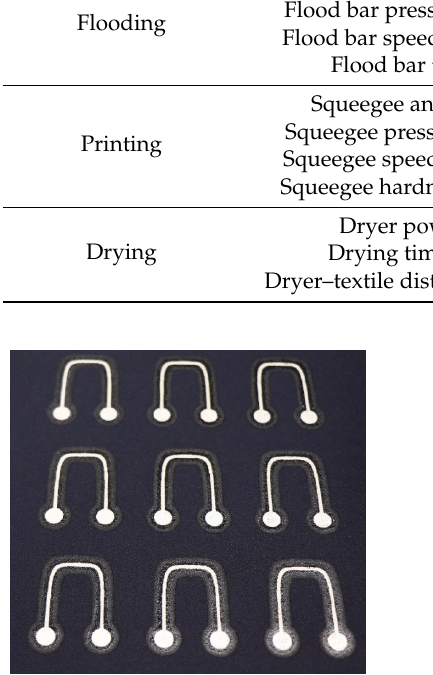
Table 4. Optimal printing and drying parameters used for each layer of the sample to be tested.